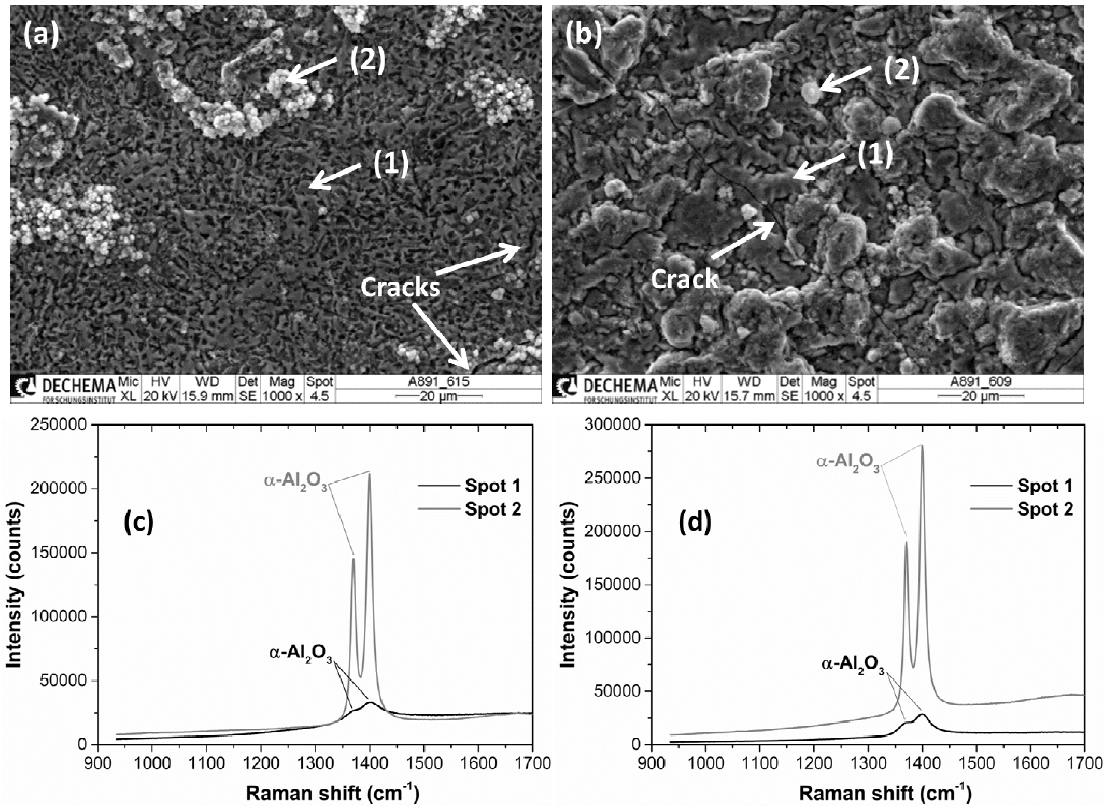
11 Figure 11. Oxidized surface morphologies and Raman spectra (fluorescence) from the marked spots of ( a , c ) aluminized and ( b , d ) Cr / Al-coated P91 after 1000 h isothermal exposure in molten solar salt at 600 ◦